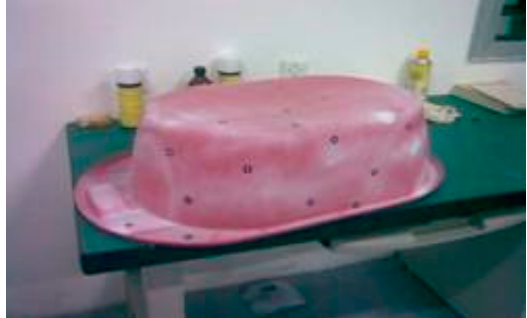
Figure 9. Sprayed Workpiece.